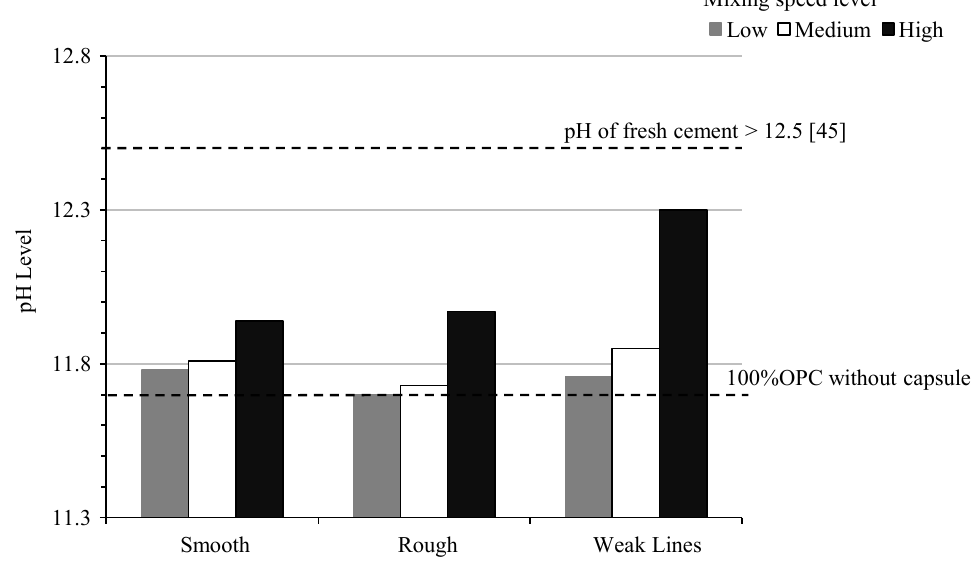
Figure 6. pH of 100%OPC concrete containing capsule after 1 h mixing.